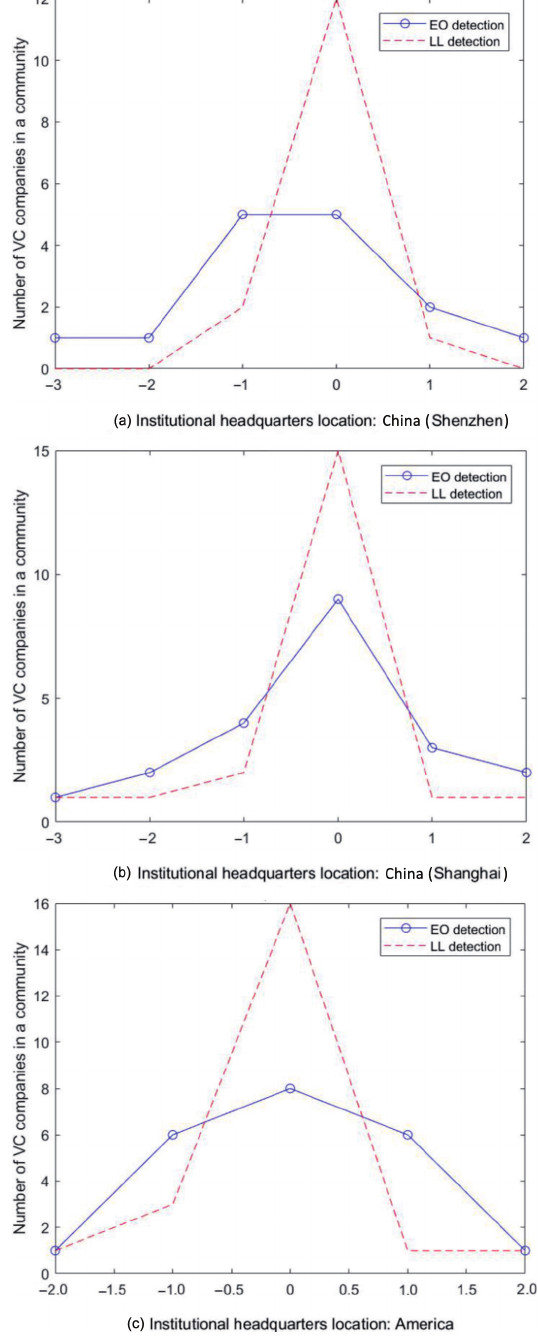
Fig. 5 “Peak map” of the aggregation degree of the institutional headquarters location of 42 VC industry leaders and 57 VC companies that have invested with them on four or more times. Here, the quantity of abscissa value has no actual meaning, it is a kind of number, which is convenient for visual